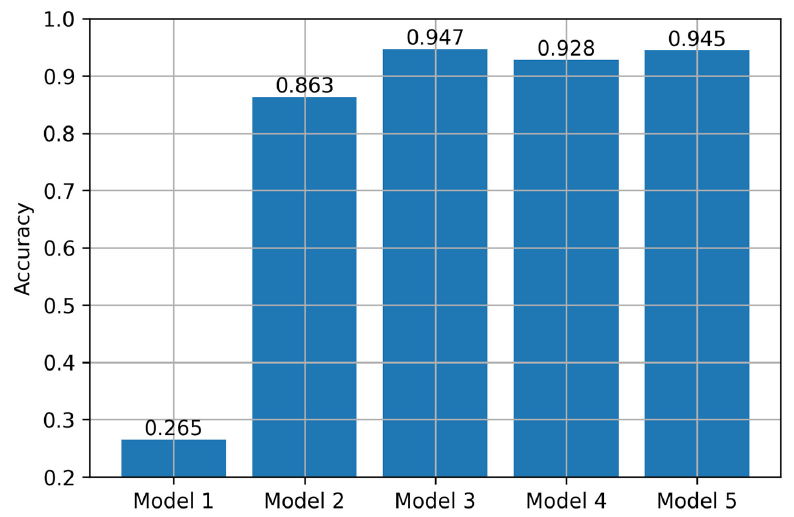
Figure 20. Accuracy of InceptionV3 models.